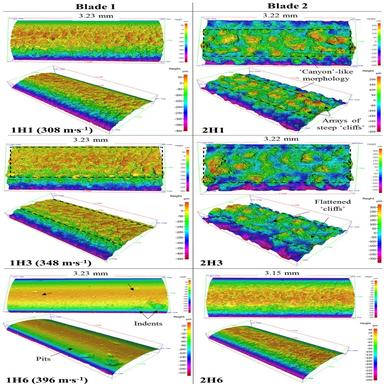
3D profiles of H1, H3 and H6 zones of both leading edges.